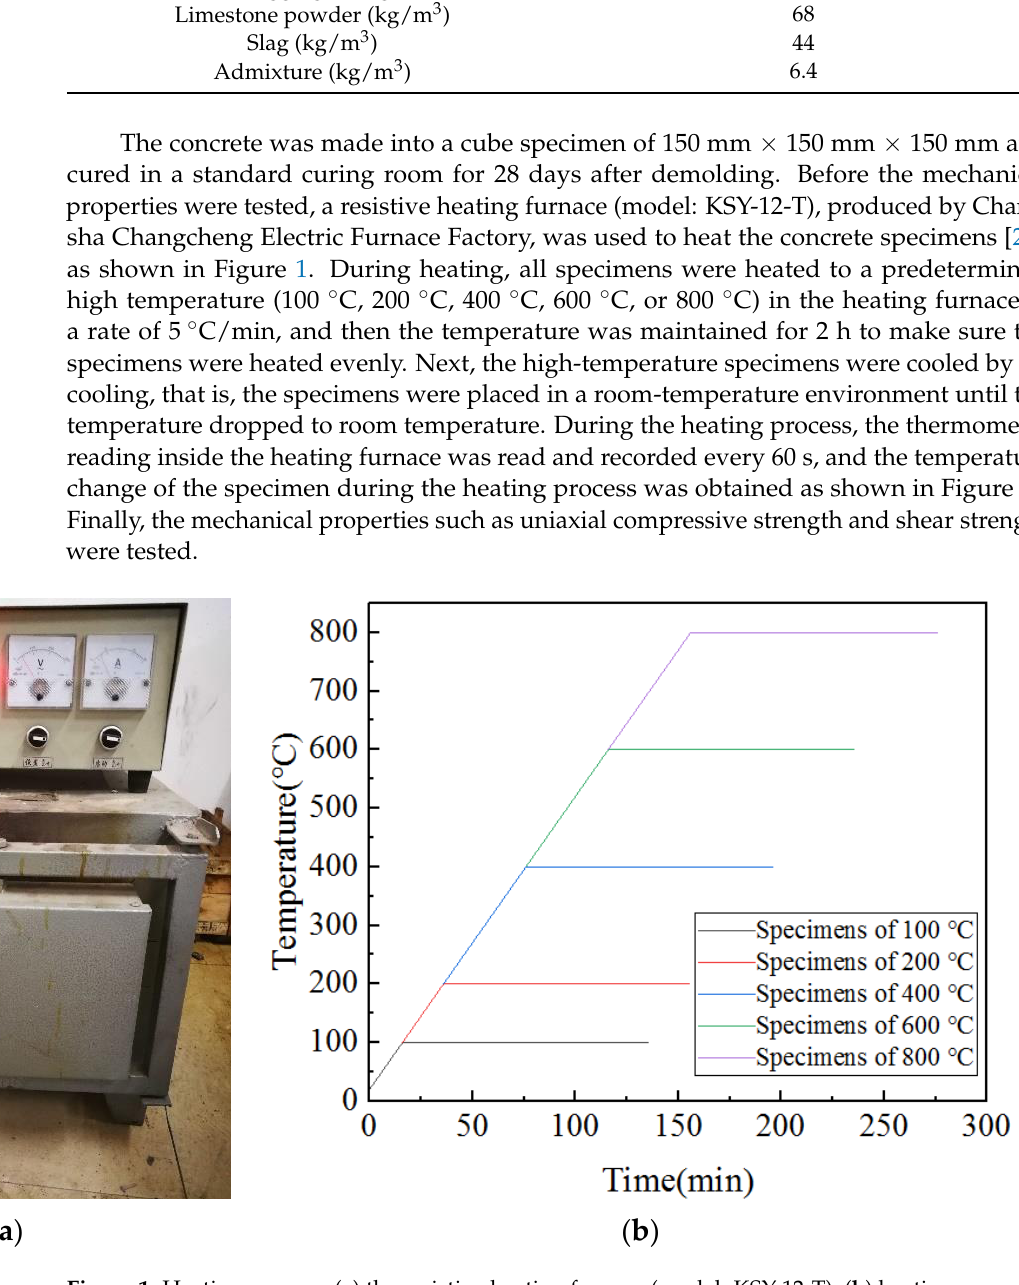
Table 1. Mix proportions of concrete.